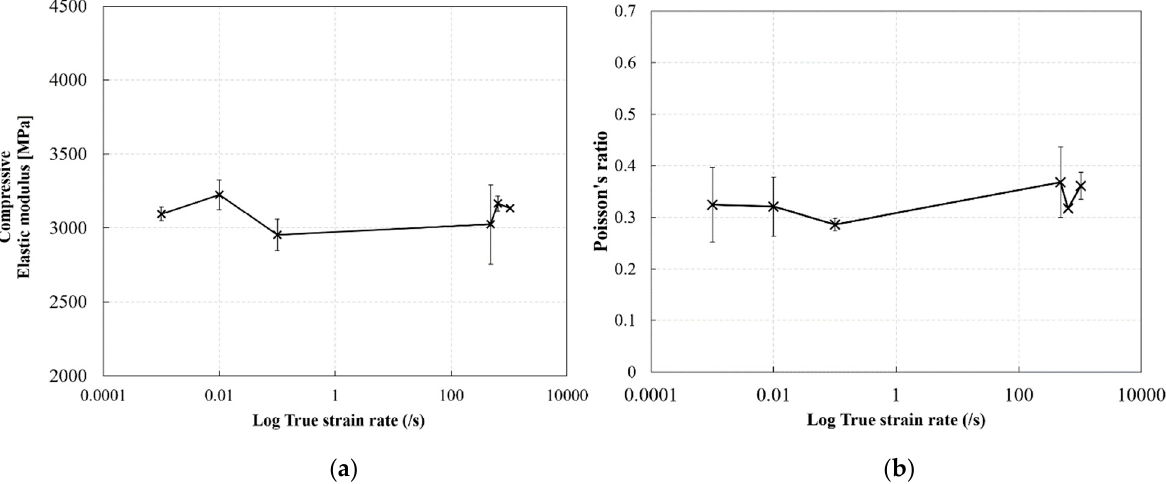
Figure 15. Effect of strain rate on the elastic constants of the RTM6 epoxy: ( a ) elastic modulus, ( b ) Poisson’s ratio.